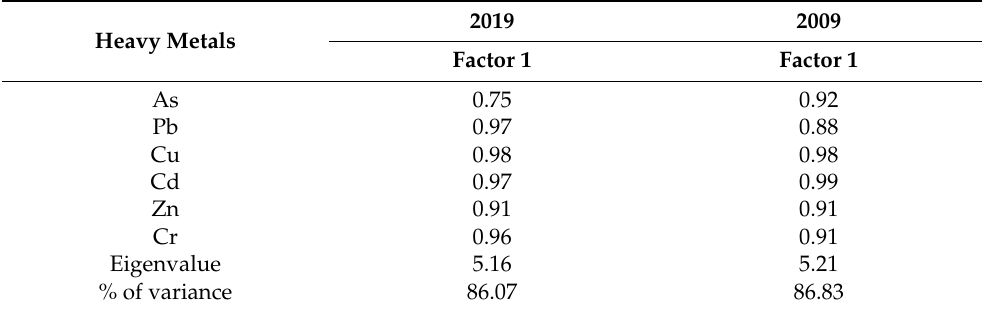
Table 7. Result of principal components matrix for metals of Huaxi Reservoir in 2019 and